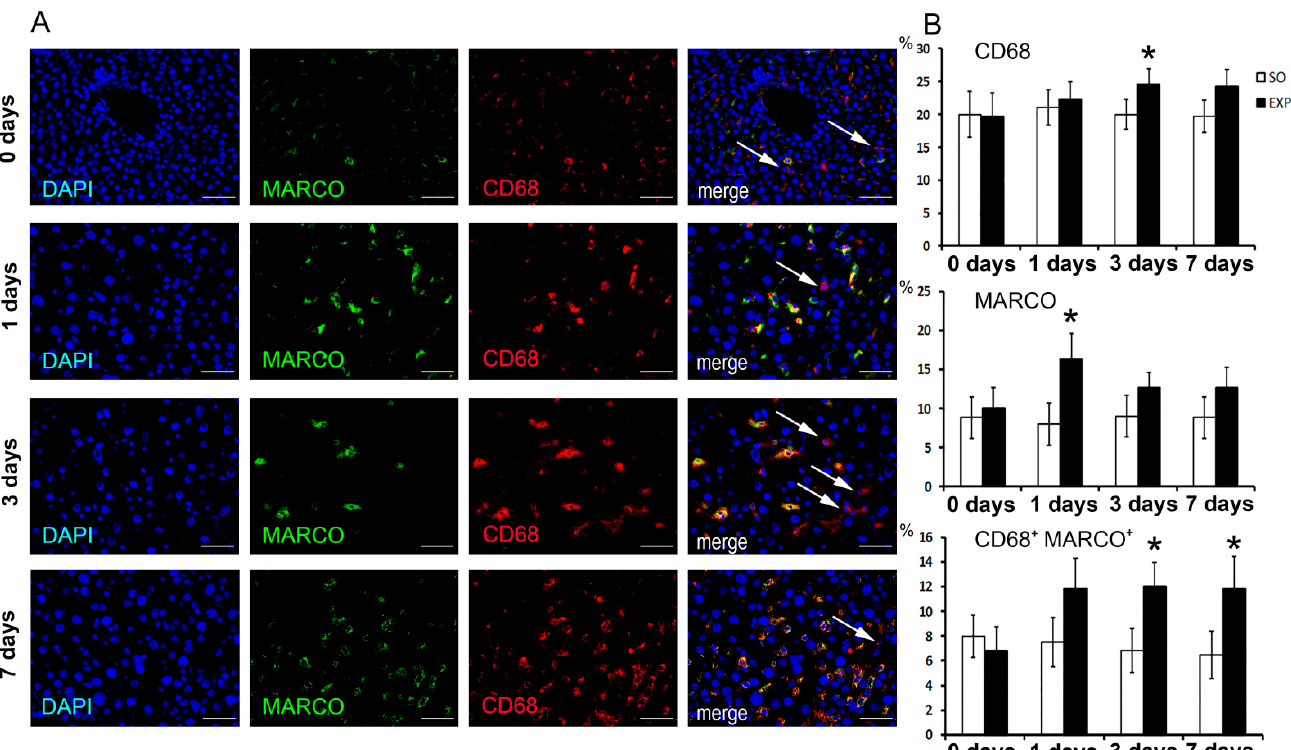
Figure 1. Immunohistochemical assessment of CD68 and MARCO expression in hepatic tissues after 70% liver resection in mice. ( A ) Fluorescent microscopy images displaying anti-CD68 (PE, red) and anti-MARCO (FITC, green) immunostaining and the counterstained cell nuclei (DAPI, blue), magnification ×400; bars, 50 μ m. Arrows indicate MARCO-negative CD68 + macrophages. Percentage values of positively stained cells are given in the plots. ( B ) The data are presented as means ± standard deviations, with at least five specimens studied for each time point after the resection. EXP—hepatectomized mice, SO—sham-operated mice, * —statistical significance of the differences with 0 h time point ( p < 0.05).